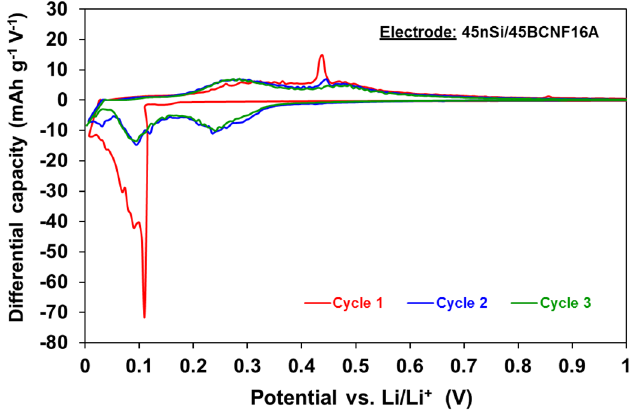
Figure 3. Di ff erential charge / discharge capacity against potential vs. Li / Li + plots from the galvanostatic Figure 3. Differential charge/discharge capacity against potential vs. Li/Li + plots from the galvanos- cycling at 100 mA g − 1 of 45nSi / 45BCNF16A electrode for cycles 1st, 2nd and 3rd, in the 2.1 V–3 mV tatic cycling at 100 mA g − 1 of 45nSi/45BCNF16A electrode for cycles 1 st , 2 nd and 3 rd , in the 2.1 V–3 mV potential potential range.